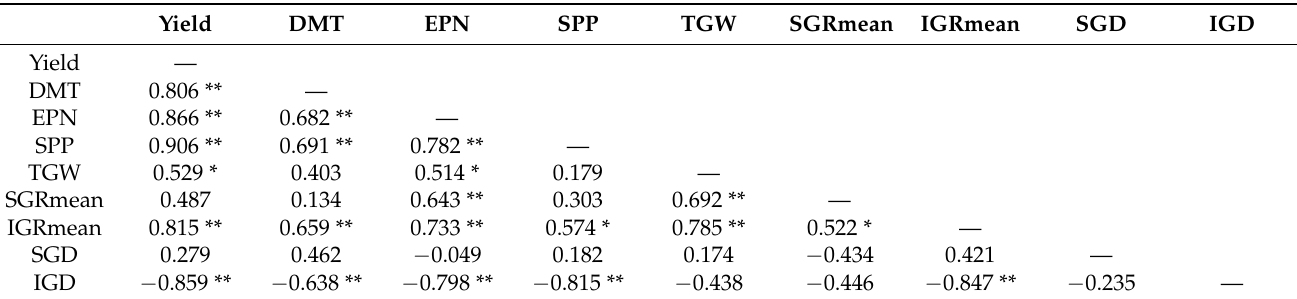
Table 5. Correlation of grain-filling characteristics with yield components.